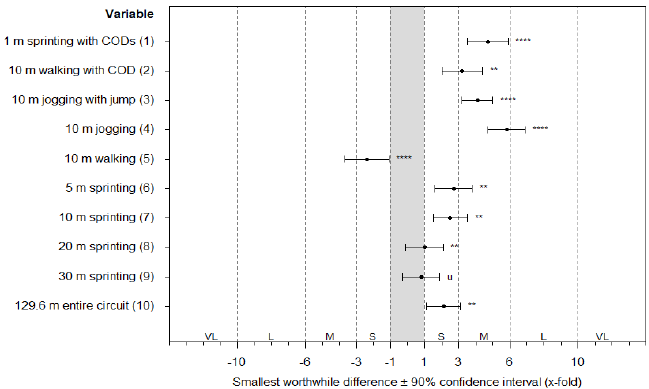
Figure 2. E ff ects of indoor vs. outdoor condition on distances covered measured by the local positioning system. For that comparison, the data of the manufacturer filter were used due to its highest validity outcomes (Table 3). Note: Each e ff ect is shown as factor of the smallest worthwhile di ff erence (SWD). The corresponding e ff ect size thresholds for small (S; 1-fold), moderate (M; 3-fold), large (L; 6-fold), and very large e ff ects (VL; 10-fold) are also shown. The asterisks *, **, ***, and **** indicate the probabilities that the e ff ect is possibly ( > 75%), likely ( > 90%), very likely ( > 95.5%), and most likely ( = 100%) higher or lower than the SWD. The letter u indicates an unclear e ff ect with probabilities of > 5% that the e ff ect is both higher and lower than the SWD. The numbers in the brackets present the section of measurement within the circuit (Figure